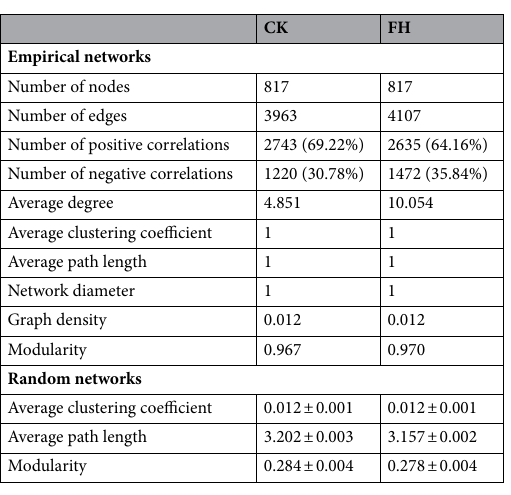
Table 4. Topological properties of rhizosphere bacterial networks obtained from different treatments. CK non-inoculated, FH inoculated with Bacillus amyloliquefaciens FH-1.